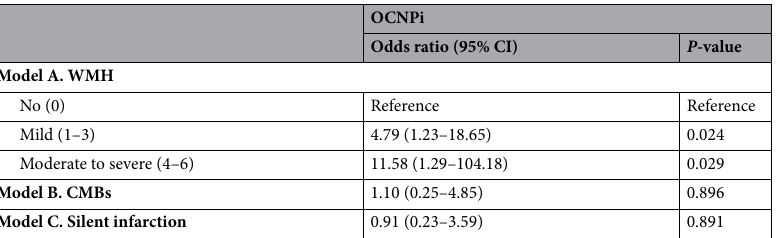
OCNPi Odds ratio (95% CI) P -value